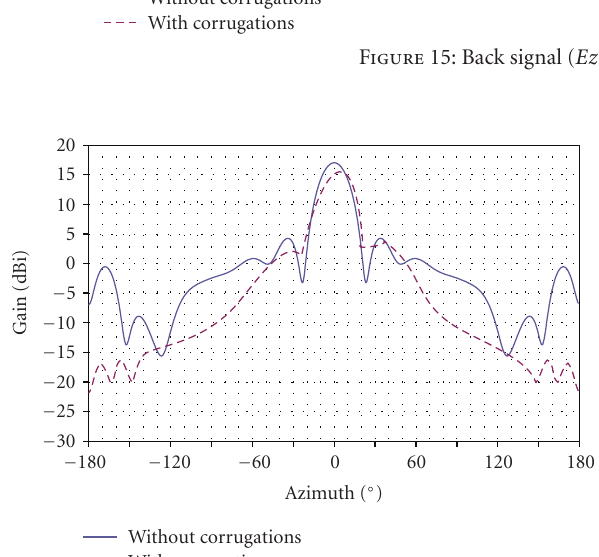
Figure 16: Gain of the array at 1,44GHz in the